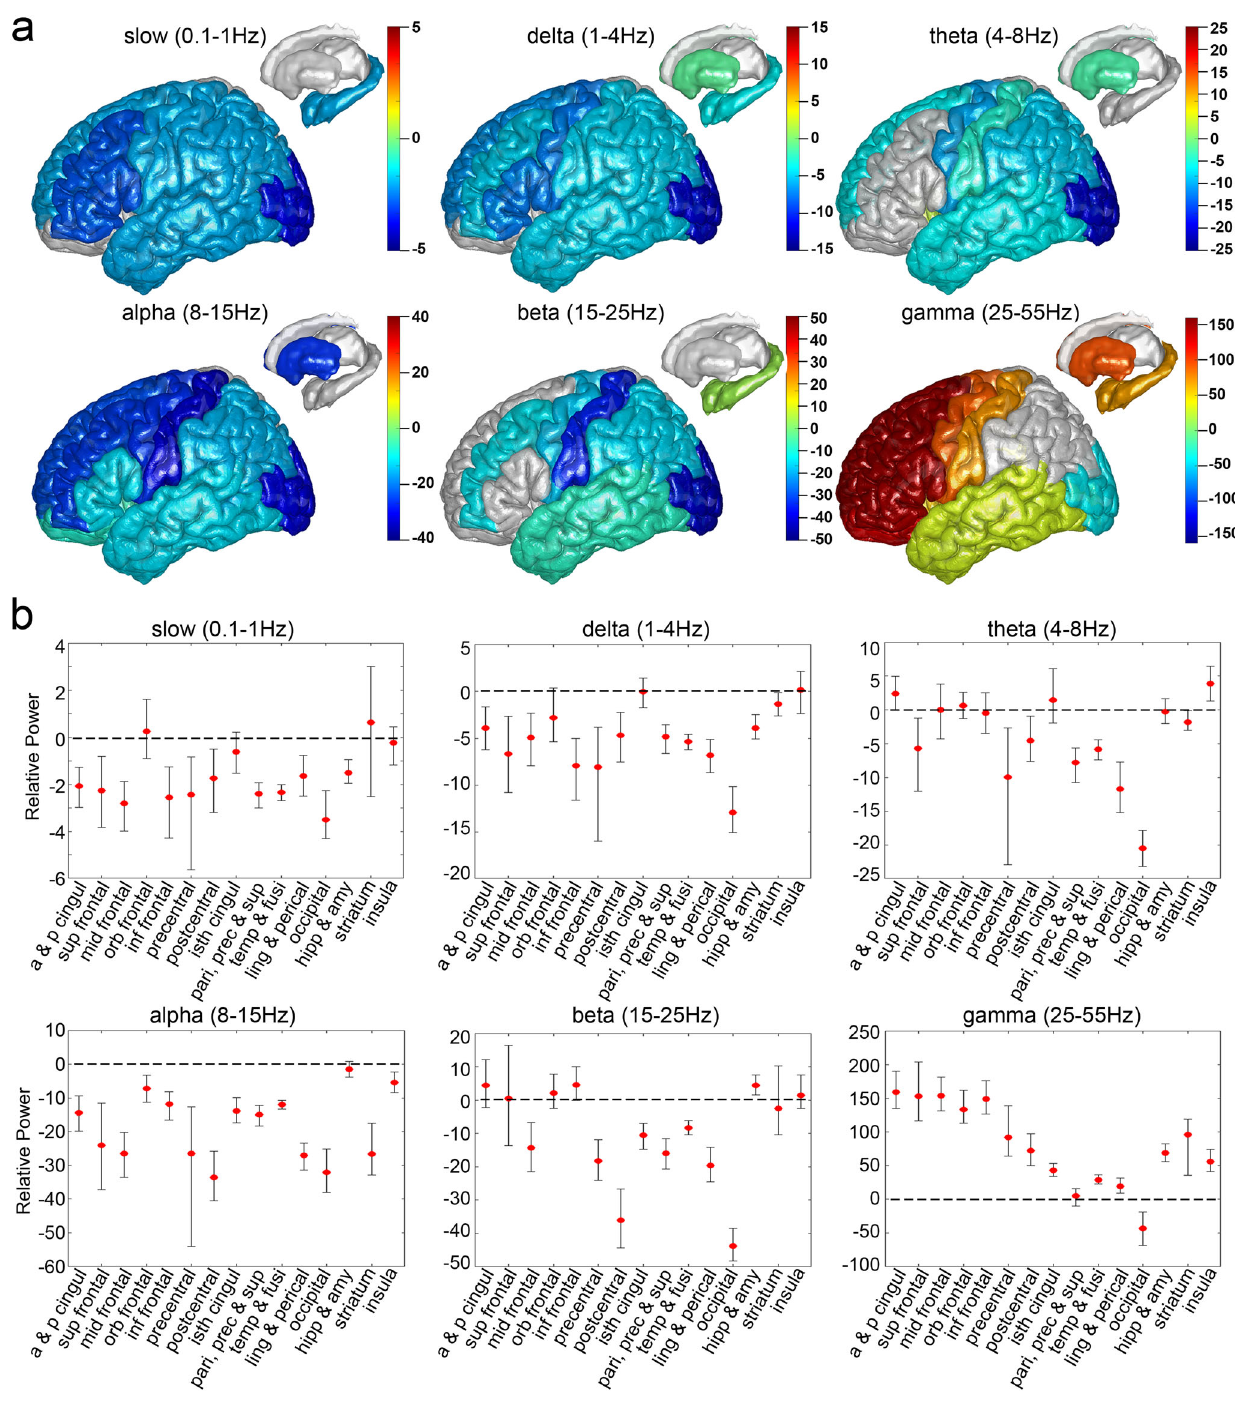
Fig. 2 | Structural mapping for intracranial EEG power changes after ketamine infusion relative to baseline at 6 frequencies. a The mean differences in power (dB) after ketamine infusion relative to baseline were calculated for 824 channels across 10 subjects and plotted on Colin 27 brain template. Warmer colors indicate an increase in power, cooler colors indicate a decrease in power, and a grey color indicates no change in power (con fi dence interval overlaps zero). b Mean and bootstrap 95% con fi dence interval for intracranial EEG power changes after keta- mine infusion relative to baseline at 6 frequencies for 15 structural labels: a & p